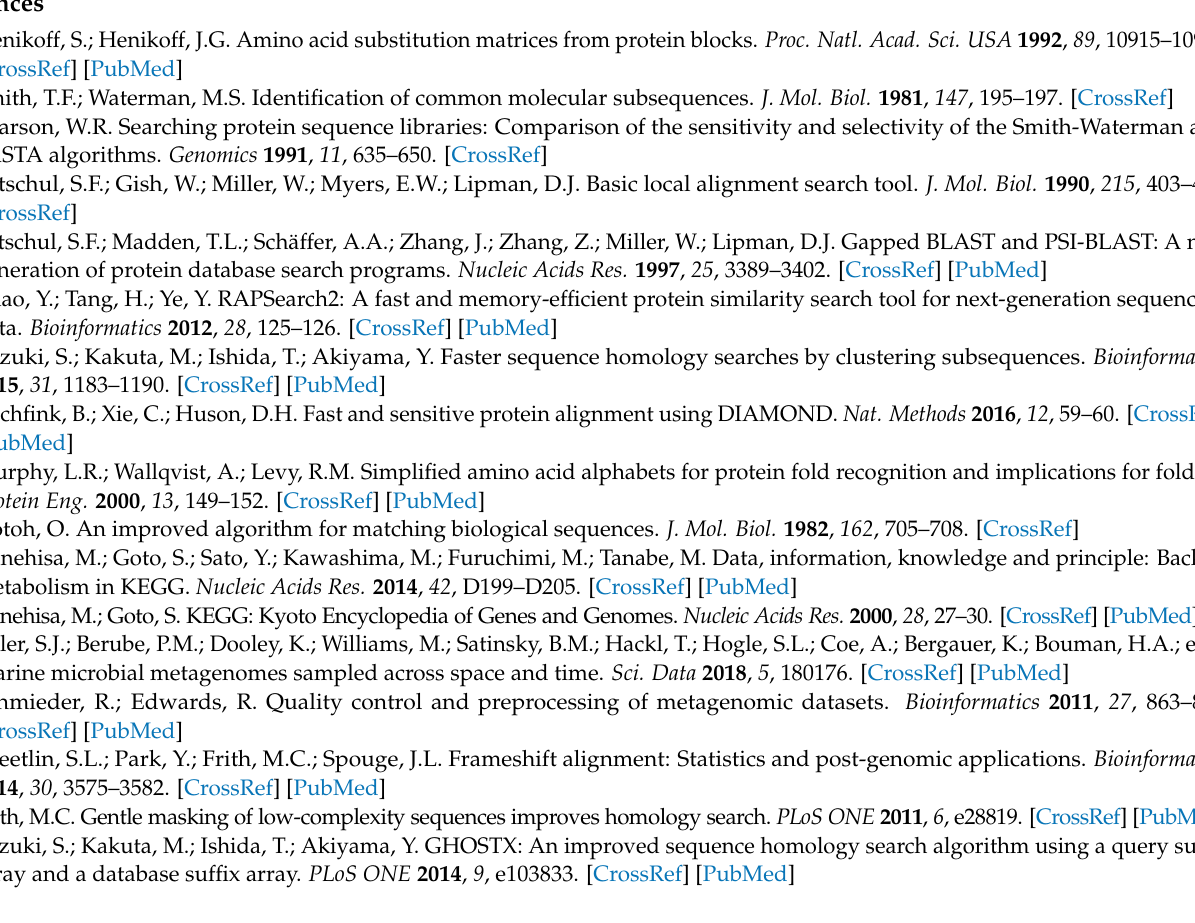
Figure S2: Boxplots based on accuracy for all combinations of A 1 and A 2 , Figure S3: Boxplots based on CPU time for all combinations of A 1 and A 2